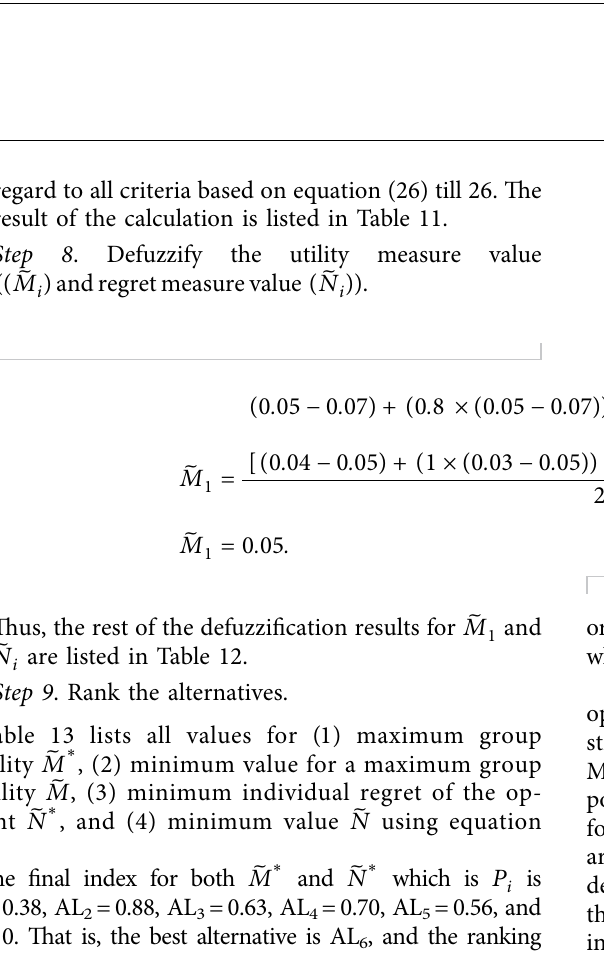
Table 8: Te entropy-based weights ( 􏽥􏽥 w